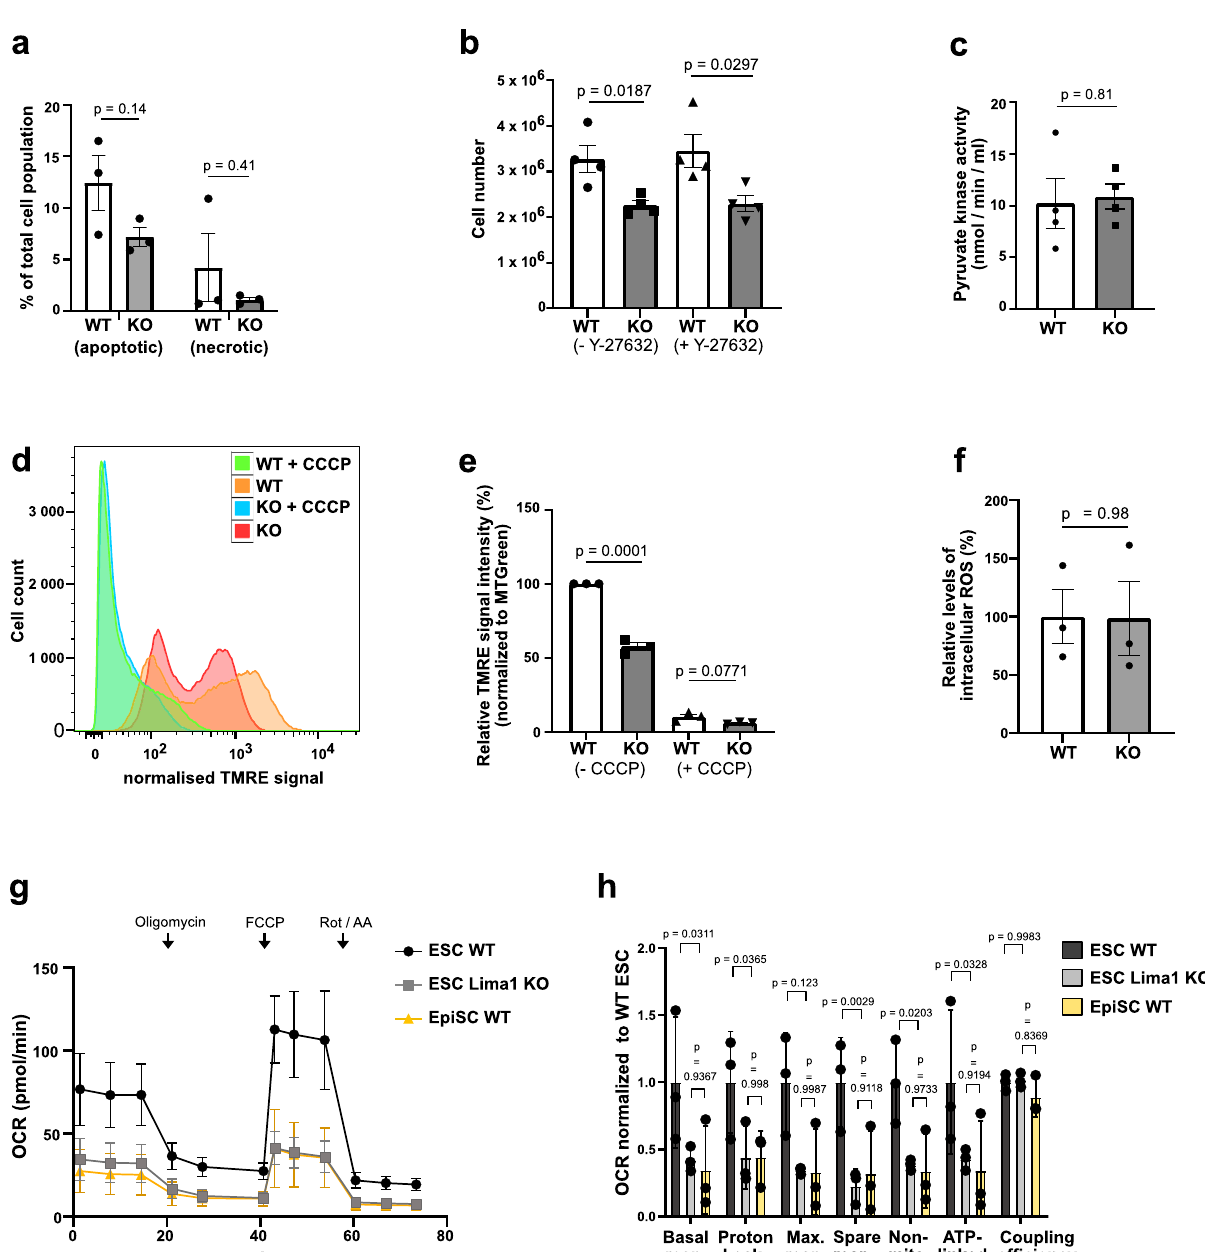
Fig. 5 Lima1 is required for proper mitochondrial energetics. a Proportion of apoptotic and necrotic Lima1 KO and WT ESC. The cells were individualized by trypsinization and cultured on cell-repellent plates for 2 h at 37 °C. After that, the cell death was determined by annexin V assay in combination with DAPI, three independent experiments, data represent mean ± SEM, unpaired Student ’ s t -test, 2-sided. b Quanti fi cation of WT and Lima1 KO cell proliferation after 96 h of culture. The cells were treated with or without Y-27632 upon dissociation. Untreated Lima1 KO ( n = 6 samples) and WT ( n = 6 samples), three independent experiments. Treated with Y-27632 Lima1 KO ( n = 6 samples), WT ( n = 6 samples), four independent experiments. Data represent mean ± SEM, unpaired Student ’ s t -tests, 2-sided. c Pyruvate kinase activity measured in WT and Lima1 KO ESC, n = 4 independent experiments. Data represent mean ± SEM, unpaired Student ’ s t -test, 2-sided. d FACS analysis of WT and Lima1 KO ESC TMRE assay. Plot shows the TMRE signal normalized to the MitoTracker signal. CCCP is a mitochondrial oxidative phosphorylation uncoupler used as a negative control. e Quanti fi cation of TMRE signal intensity, normalized to MitoTracker signal intensity, n = 3 independent experiments. Data represent mean ± SEM, unpaired Student ’ s t -test, 2-sided. f Quanti fi cation of relative intracellular ROS levels in Lima1 KO ESC, relative to WT ESC. Three independent experiments, data represent mean ± SEM, unpaired Student ’ s t -test, 2-sided. g OCR measurement using the Seahorse mitochondrial stress test assay. FCCP − Carbonyl cyanide-4 (tri fl uoromethoxy) phenylhydrazone; Rot Rotenone, AA − Antimycin. Three independent experiments, mean values ± SEM. h Quanti fi cation of the OCR analysis, n = 3 independent experiments. Data represent mean ± SEM, 2-way ANOVA with Tukey ’ s multiple comparisons. Related to Fig. S4.